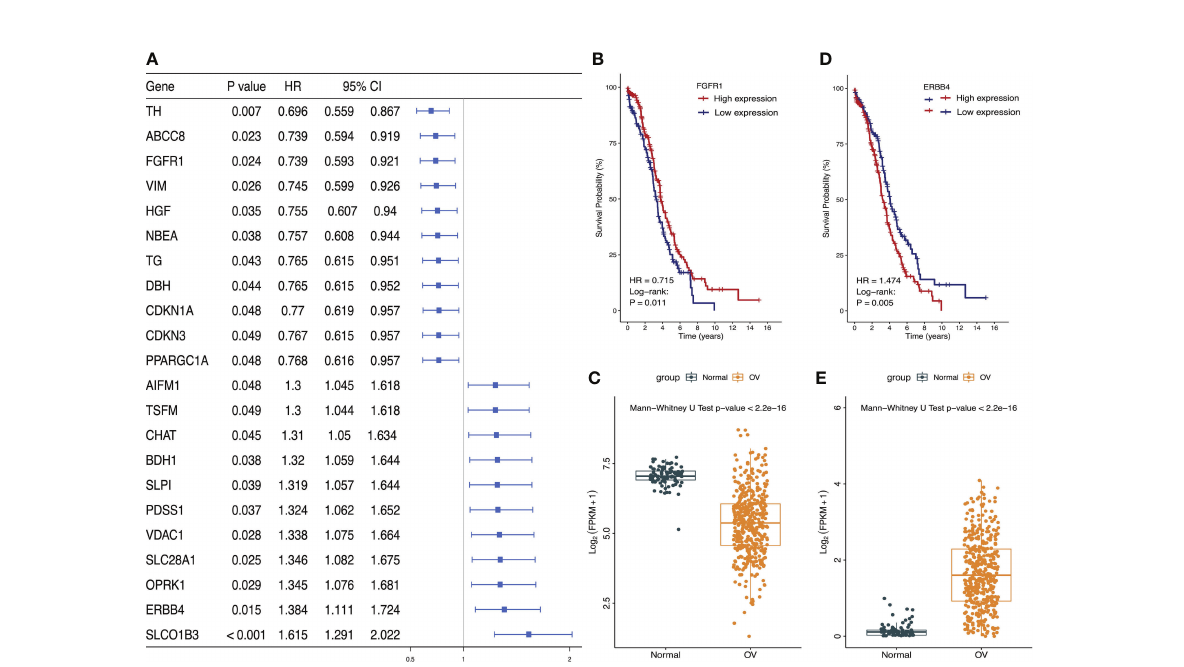
FIGURE 2 Identi fi ed the most signi fi cant LMRGs related to ovarian cancer risk. (A) Identi fi cation of LMRGs associated with ovarian cancer patient prognosis based on univariate Cox regression analysis. (B, C) Survival analysis of FGFR1 and its expression level in ovarian cancer and normal ovarian tissues. (D, E) Survival analysis of ERBB4 and its expression level in ovarian cancer and normal ovarian tissues. P < 0.05 was considered to be statistically signi fi